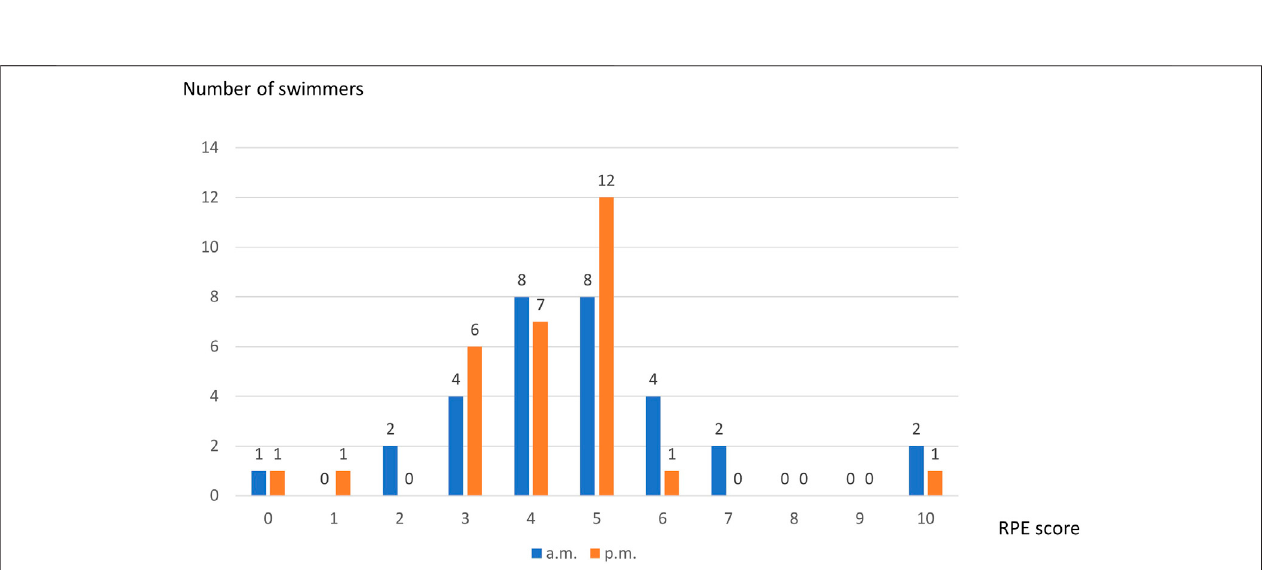
FIGURE 4 | Distribution of RPE scores after swimming session in the morning and in the afternoon.